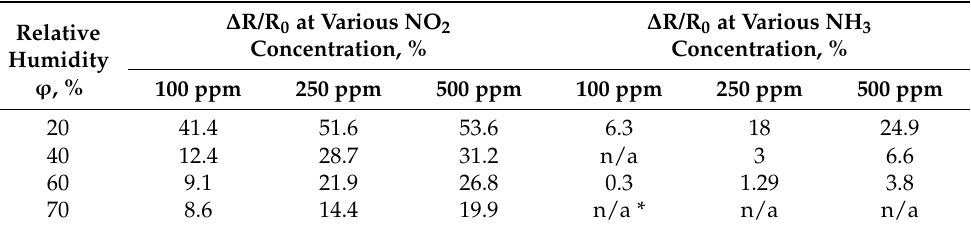
Table 1. Effect of relative humidity of air on the response of sensors based on granulated CNF material at room temperature (25 ± 2 ◦ C, air) to NO 2 and NH 3